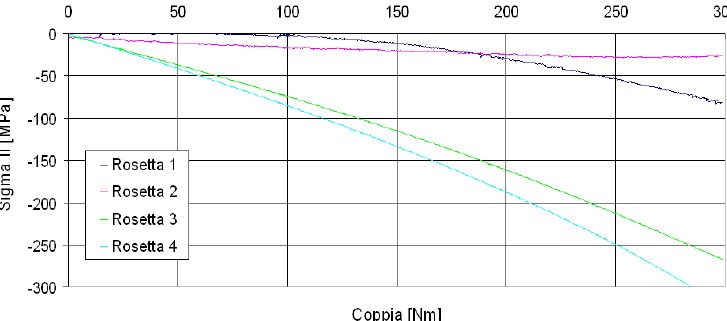
Figura 16: Andamento dello sforzo principale σ II durante la prova